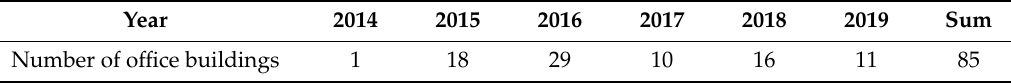
Table 2. Measurement system installation schedule in sample o ffi ce buildings.